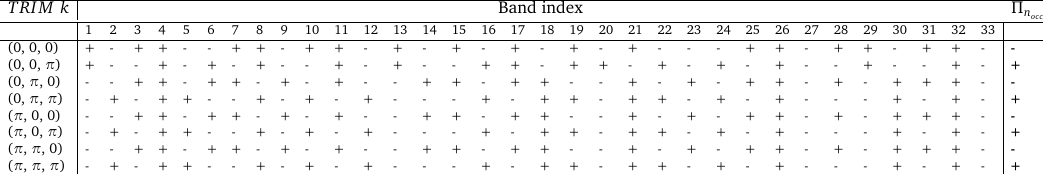
Table 1: Parity eigenvalues at TRIM points in LiCoO number of occupied bands for the hexagonal unit cell( n + 2 × (O-s + 3 O-p) ) = 3 × 11 = 33. One can see that the inversion eigenvalue at = 0 and k = π is inverted for all the TRIM points in the hexagonal Brillouin zone. k z z TRIM k Band